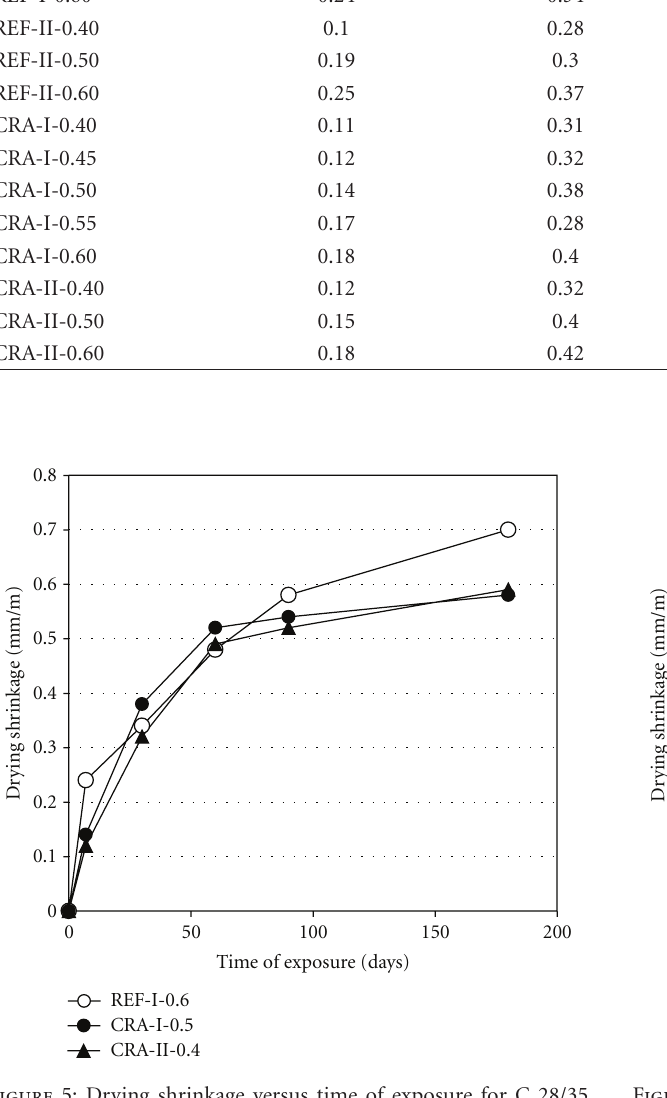
Figure 5: Drying shrinkage versus time of exposure for C 28/35 strength class concretes.